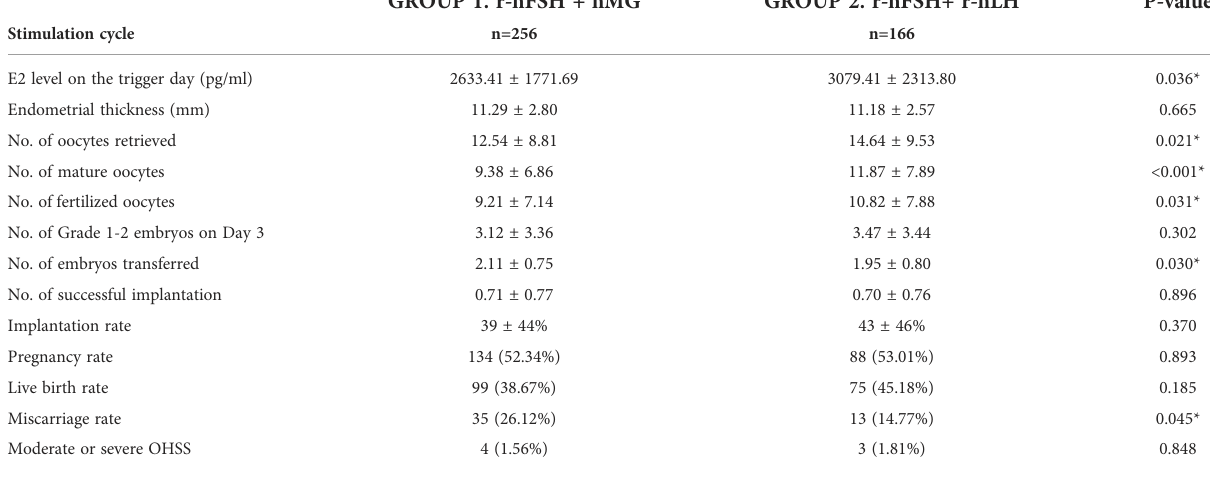
TABLE 3 Outcomes of 1 st ET